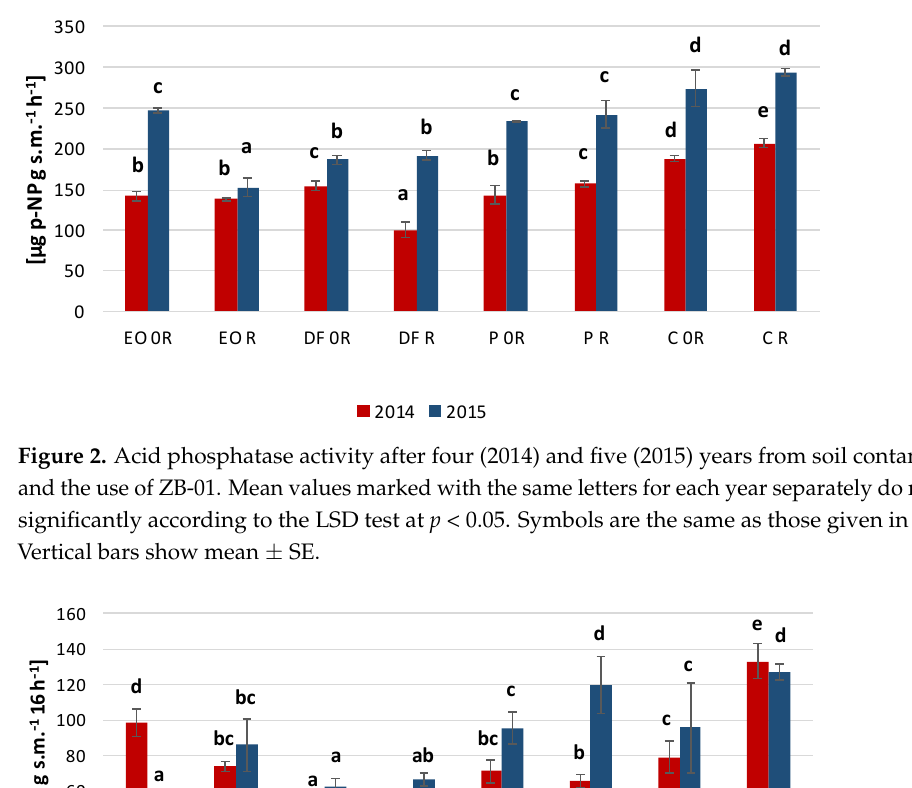
Figure 1. Alkaline phosphatase activity after four (2014) and five (2015) years from soil contamination and the use of ZB-01. EO—soil contaminated with engine oil, DF—soil contaminated with diesel fuel, P—soil contaminated with petrol, C—control soil, 0R—without bioremediation, R—with bioremediation. Mean values marked with the same letters for each year separately do not differ significantly according to the LSD test at p < 0.05. Vertical bars show mean ± SE.